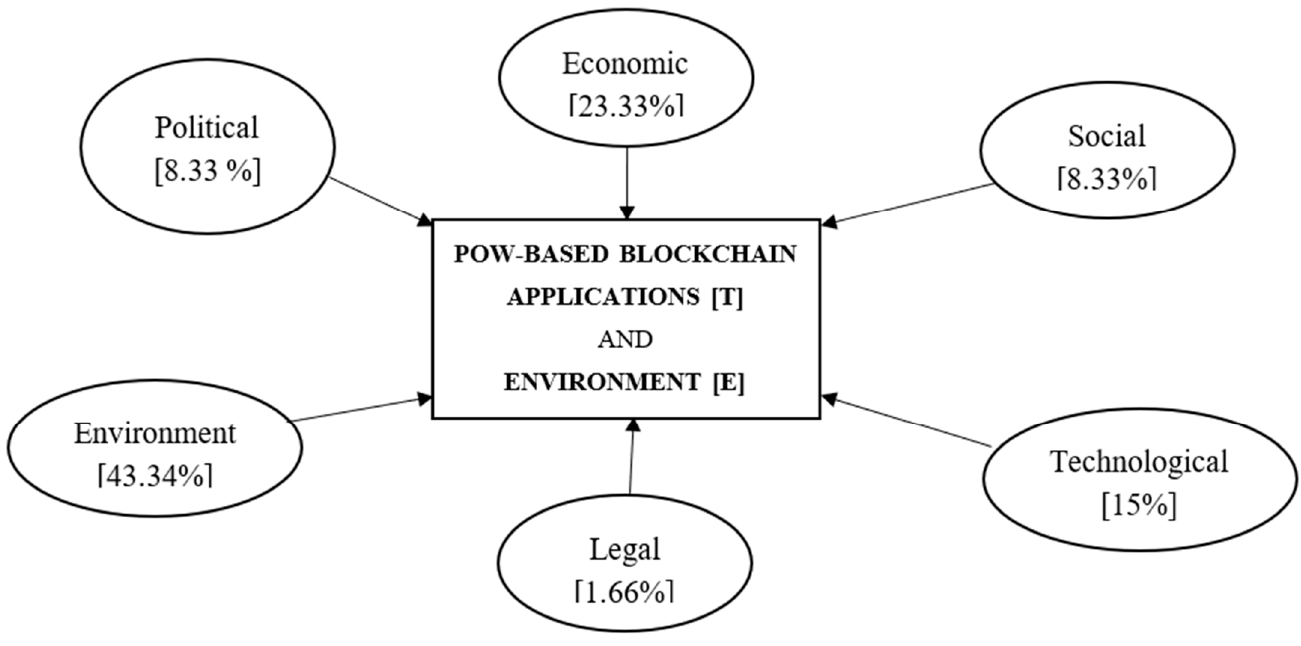
Figure 7. PESTLE perspective-based contextualization.